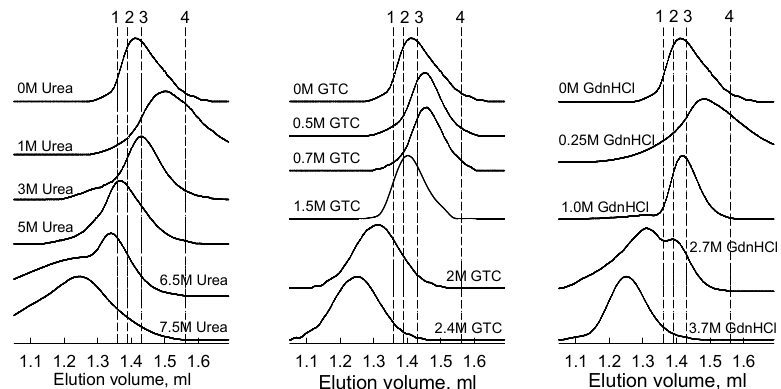
Figure 7. Changes in hydrodynamic dimensions at holoform iRFP713 unfolding induced by urea ( left panels ), by GTC ( central panels ), and by GdnHCl ( right panels ). Changes in elution profile of iRFP713 in the holoform at increasing denaturant concentration. Numerals at the curves specify applied denaturant concentration. Dotted lines designate the positions of the elution peaks of proteins with a known molecular mass used for calibration of the column: 1–158 kDa (aldolase); 2–75 kDa (conalbumin); 3–44 kDa (ovalbumin); 4–29 kDa (carbonic anhydrase).